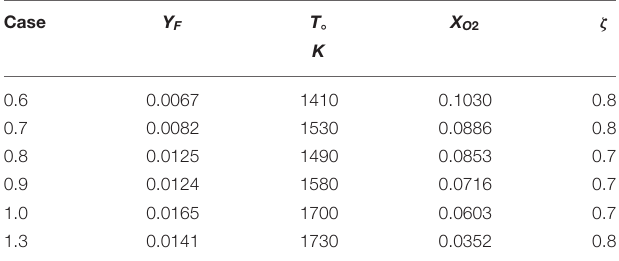
reaction is reduced, the critical points on each mixture’s S-Shaped Curve disappear, marked with a transition from a bold, patterned to dotted line in Figure 5 . The point of this transition is marked